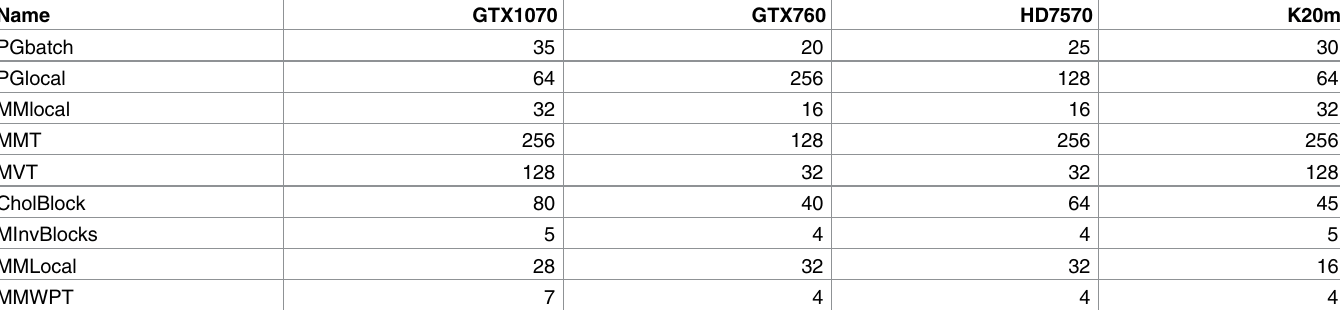
Table 4. Values of the tunable parameters in the experimental evaluation.